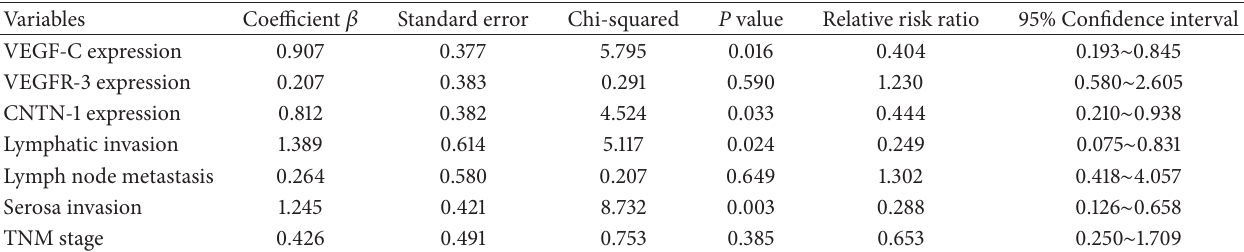
Table 6: Multivariate survival analysis (Cox proportional hazards